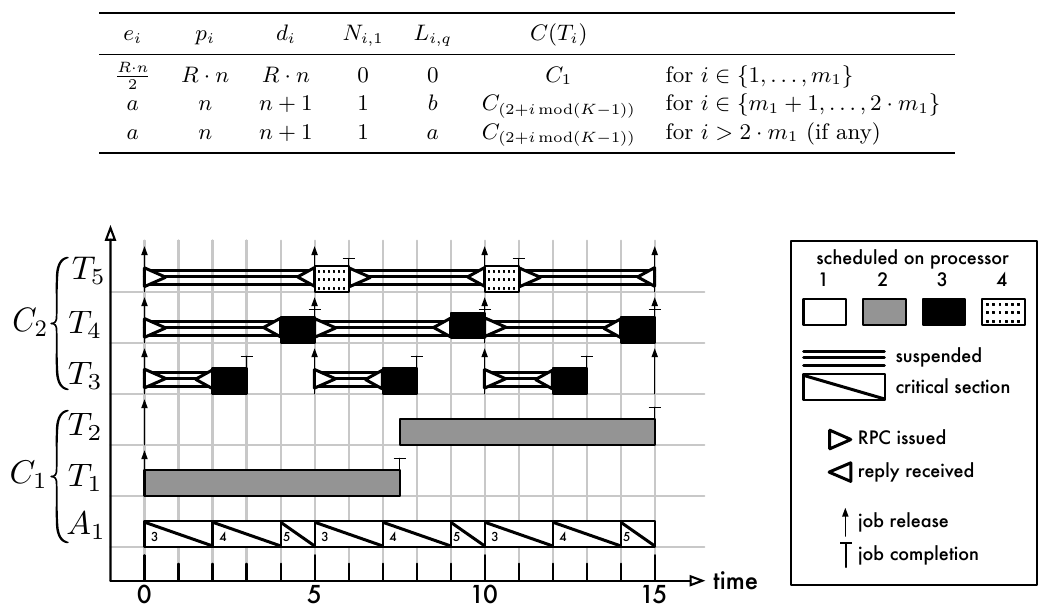
Figure 1 Example schedule of the task set τ seq ( n, m 1 , R ) as specified in Table 2 for K = 2, m 1 = 2, m 2 = 2, n = 5, and R = 3. There are five tasks T 1 , . . . , T 5 assigned to K = 2 clusters sharing one resource ‘ 1 , which is local to cluster C 1 . Agent A 1 is hence assigned to cluster C 1 . The small digit in each critical section signifies the task on behalf of which the agent is executing the request. Deadlines have been omitted from the schedule for the sake of clarity. By construction, the scheduling policy employed to schedule jobs is irrelevant (for simplicity, assume FP scheduling, where lower-indexed tasks have higher priority than higher-indexed tasks). The response-time of T 2 is r 2 = n · R = 5 · 3 = 15 since it has the lowest priority in its assigned cluster C 1 , and because agent A 1 is continuously occupying a